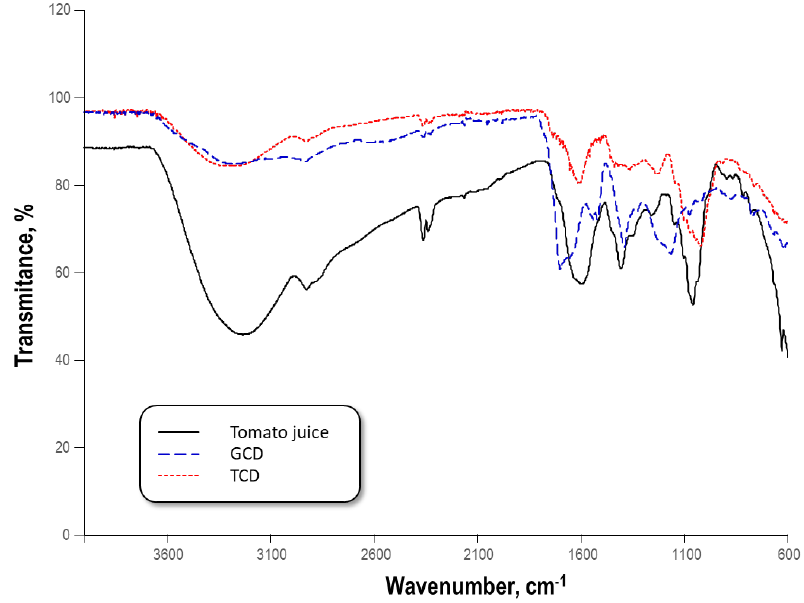
Figure 3. FTIR spectra of (black solid line) tomato juice, (blue dashed line) GCD and (red dotted line) TCD.